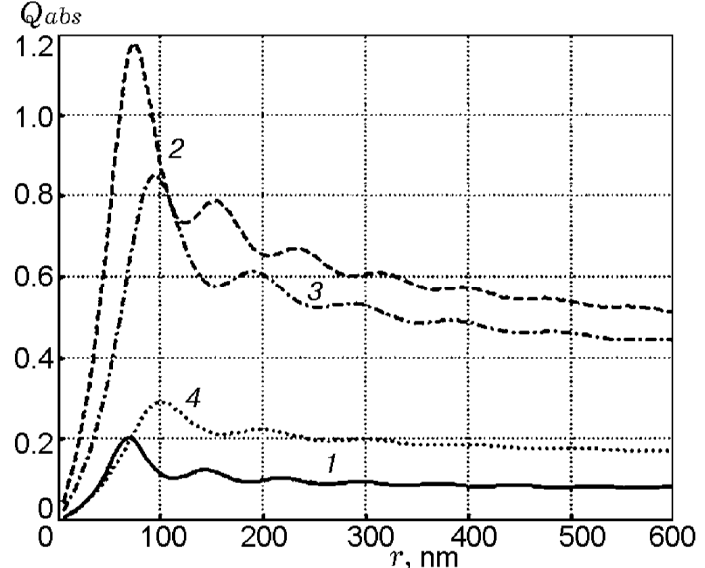
Figure 19. Efficiency of radiation absorption ( λ = 1064 nm) by metallic inclusions in a matrix of energetic materials vs. radius of inclusions: Ag in AgN 3 matrix ( 1 ), Pb in PbN 6 matrix ( 2 ), and Pb and Al in PETN matrix ( 3 and 4 ). Reproduced from [61], with permission from Combust., Explos., Shock Waves, 2012.